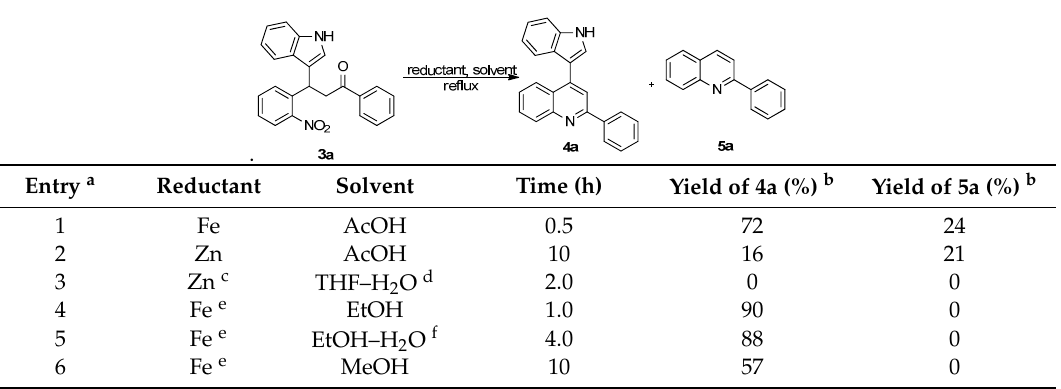
Table 3. Optimization studies for reductive cyclization of 3-(1H-indol-3-yl)-3-(2-nitrophenyl)-1-